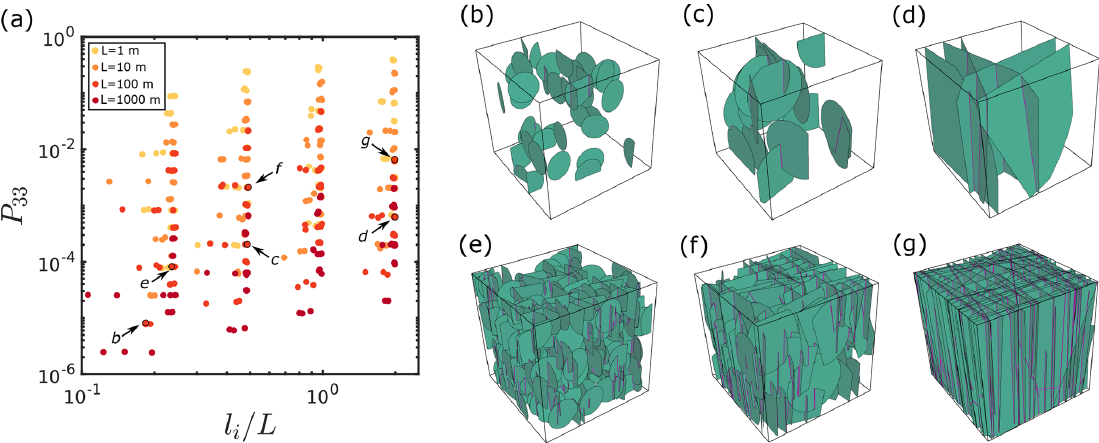
Figure 7. Panel (a) visualizes the geometrical configurations of all 381 test DFNs as a function of their global P 33 value and their ratio between maximum intersection length l i and system size L . Colors indicate the model size L . Note that high global fracture porosities are predominantly achieved for smaller system sizes for the considered test cases. Panels (b–g) show the underlying DFN structure of the models indicated in (a) with system sizes of 100m. Fractures are approximated with green disks and intersections with magenta lines. Panels (b–d) have a low prescribed number of fractures (10 × L/ 2 l ), whereas (e–g) have a high prescribed number of fractures (100 L/ 2 l ). The ratio of constant fracture length l and system size L for (b, e) is 0 . 25, 0 . 5 for (c, f) , and 1 for (d, g) .